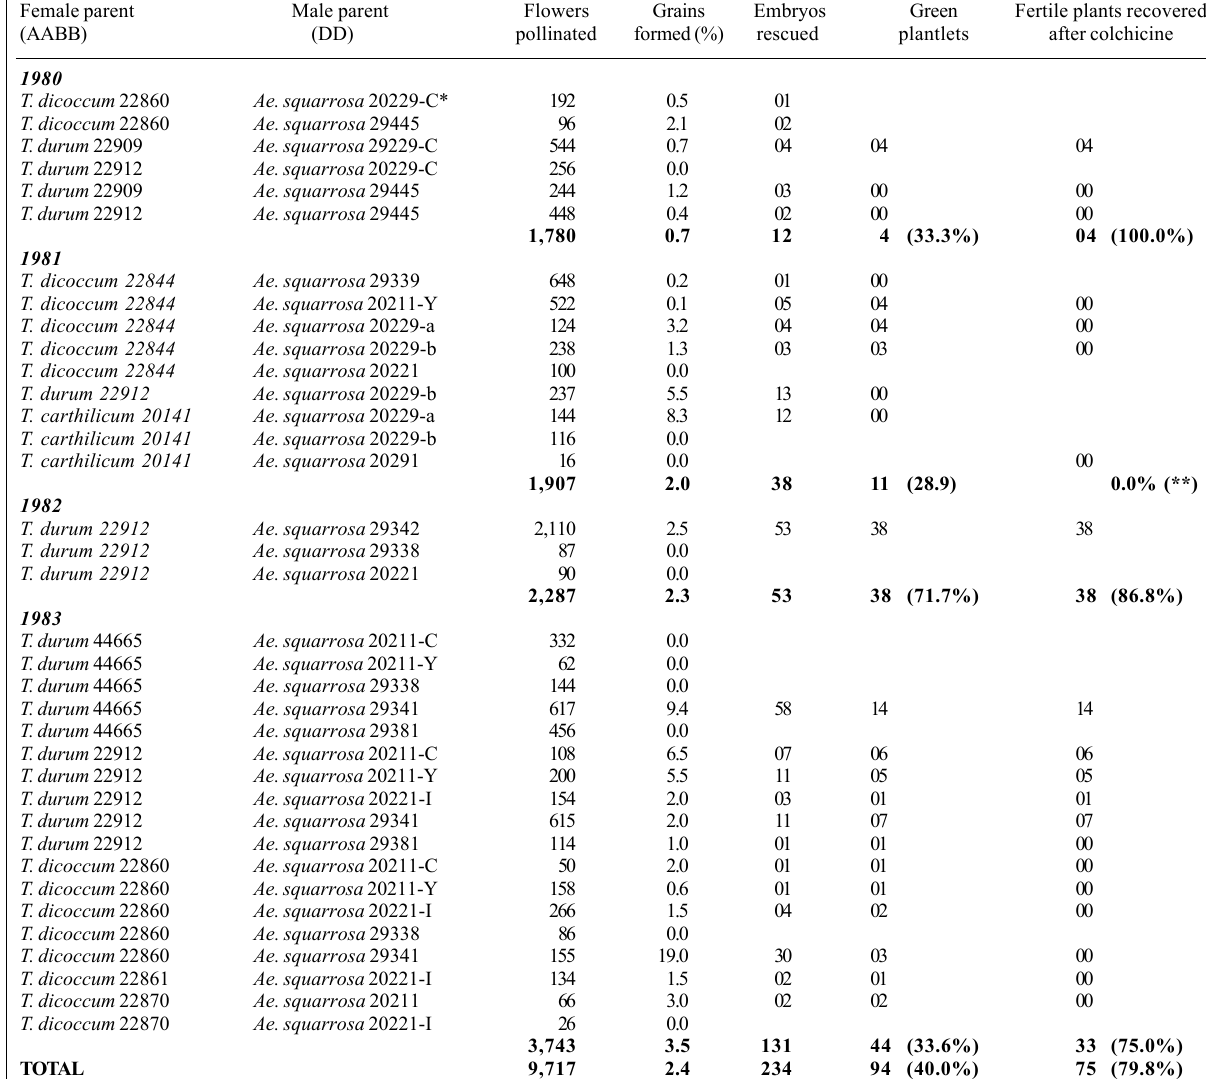
Table I - Results of crosses between tetraploid species (AABB) and Aegilops squarrosa